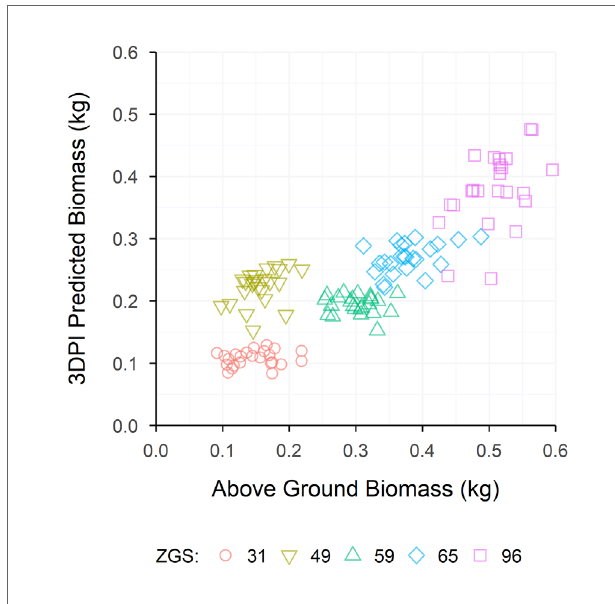
FIGURE 9 | The relationship between 3DPI Biomass and manually measured Above-ground Biomass, for each sample time at Roseworthy. Coloured shapes indicate measurements collected at Zadoks growth scales (ZGS) as follows, red circles at ZGS 31, yellow triangles at ZGS 49, green triangles at ZGS 59, blue diamonds at ZGS 65 and pink squares at ZGS